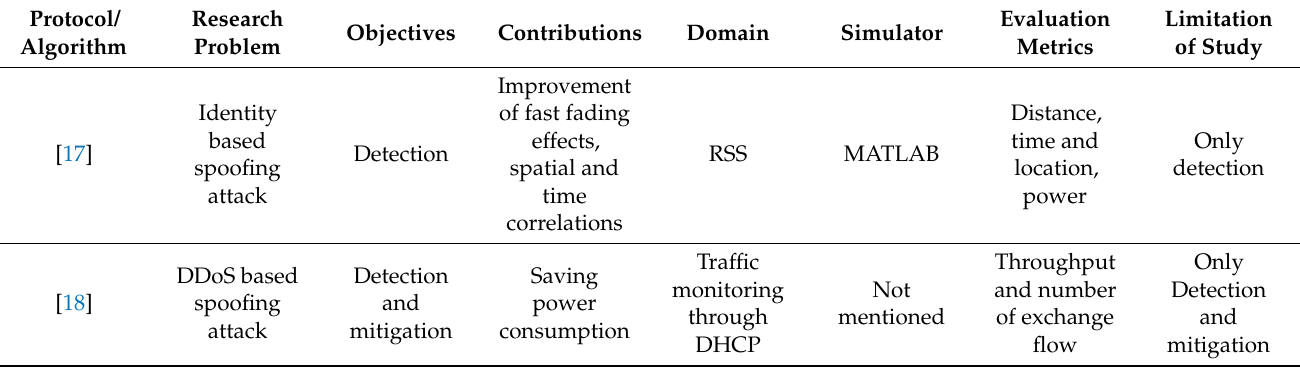
Table 1. Comparison of